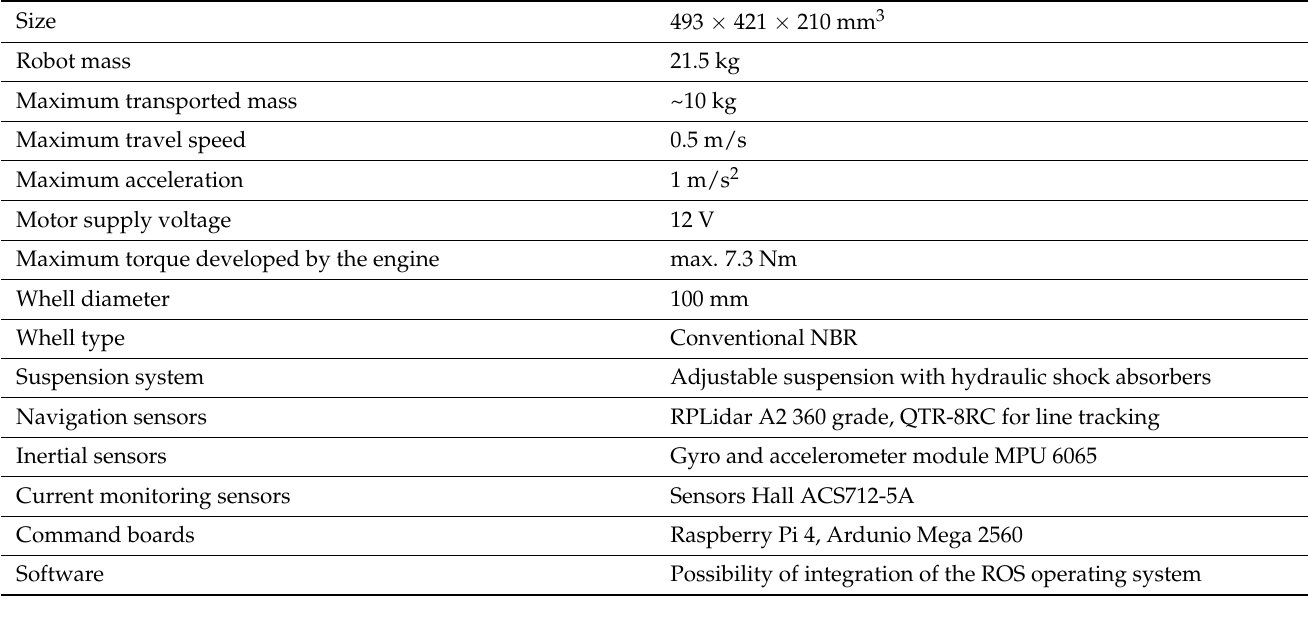
Table 2. Technical characteristics of the conventional two-wheeled modular mobile robot.